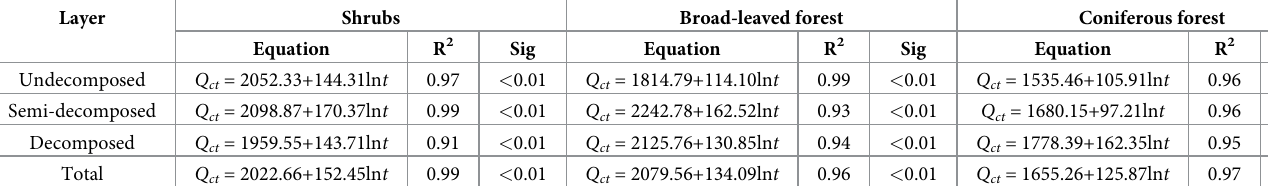
) and immersion time(t). ct